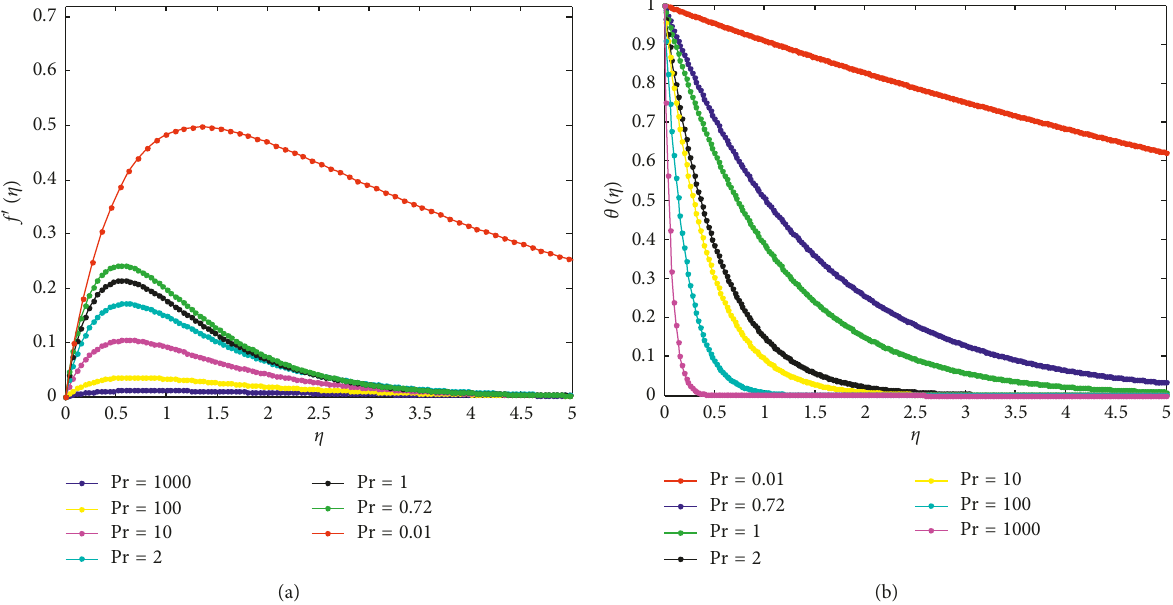
Figure 9: (a) Effects of Prandtl number on the velocity profile when ϕ � 0.080. (b) Effects of Prandtl number on the temperature profile when ϕ �